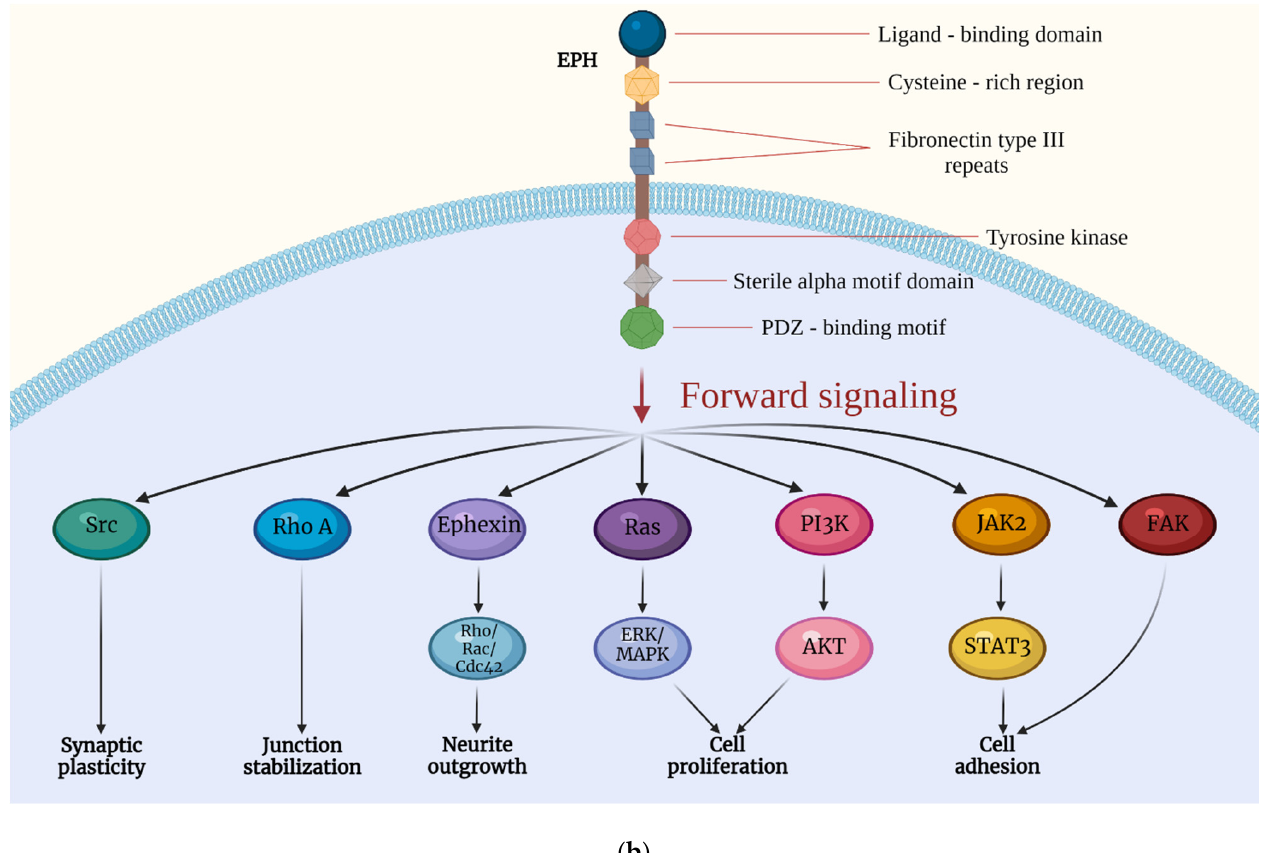
Figure 2. A response is triggered in both the ephrin-expressing cell ( a ) and the EPH-bearing one ( b ). Following EPH–ephrin interaction, an action is triggered in both cells through complex molecular mechanisms, as EPHs/ephrins interact with various molecular cascades to further convey the message into the cytoplasm. Forward signaling includes interaction of EPHs with the Src family kinases, resulting in the regulation of synapses formation, with Rho GTPases leading to junction stabilization as well as interaction with Ephexins and the ERK/MAPK pathway leading to cell proliferation. Moreover, EPHs interact with FAK and the JAK/STAT pathway, resulting in modulation of cell ad- hesion. Mechanisms implicated in reverse signaling include, among others, interaction between ephrins and Src, Erk, Rac, ΑΚΤ , paxillin, and p75, leading to integrin-dependent cell adhesion as well as with Src, Grb4, PTP-BL, and PDZ-RGS3, regulating various actions such as cell adhesion,